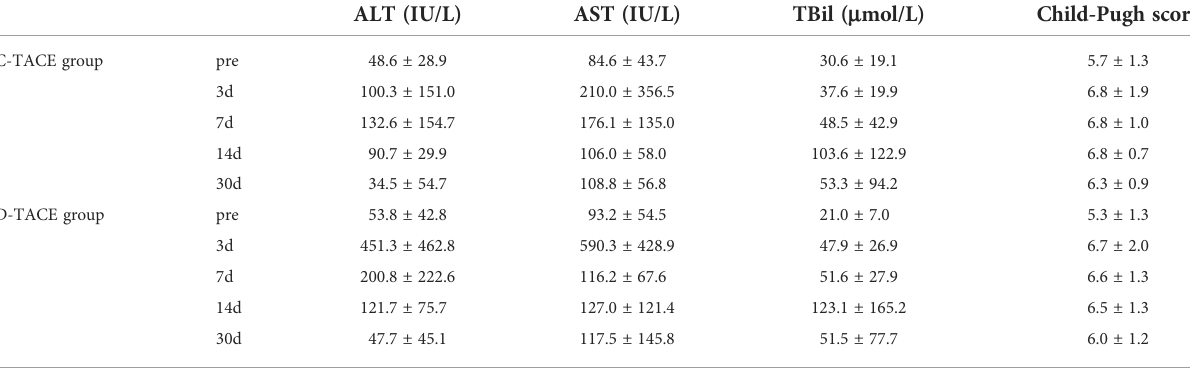
TABLE 2 Liver function parameters before and 3 days, 7 days, 14 days, 30 days after interventional procedures. ALT (IU/L) AST (IU/L) TBil ( m mol/L)